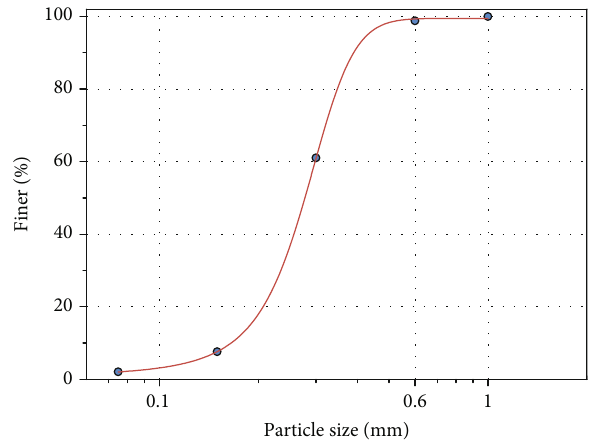
Figure 5: Grading curves for the natural Aeolian sand.